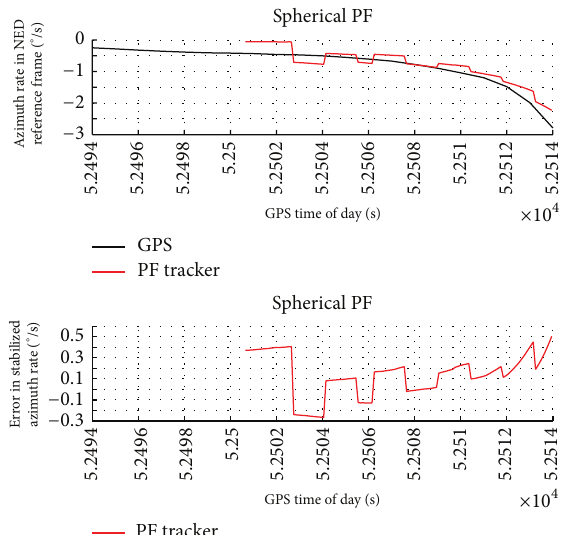
Figure 9: Azimuth rate in NED reference frame as estimated by GPS and by radar-only tracker and estimation error as a function of GPS time of